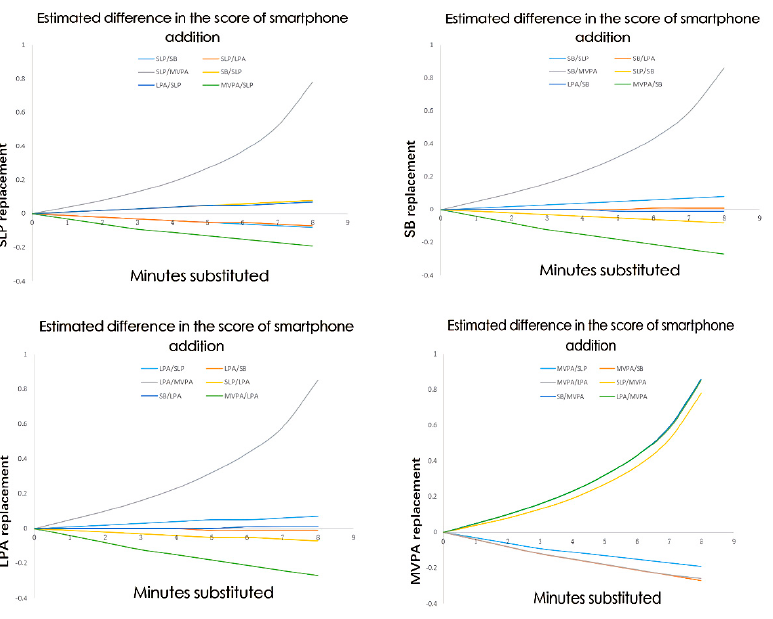
Figure 2. Changes in the scores of smartphone addiction after one activity replacing other behaviors at the different fixed durations of time. LPA, light-intensity physical activity; MVPA, moderate-to- vigorous-intensity physical activity; SB, sedentary time; SLP, sleep duration. X-axis represents the number of minutes substituted. Y-axis represents the estimated difference in the score of smartphone addiction. All models are adjusted for age, sex, grade, only child or not, BMI, regular exercise, anxiety, parents’ education level, and whether work on the front line of the epidemic or